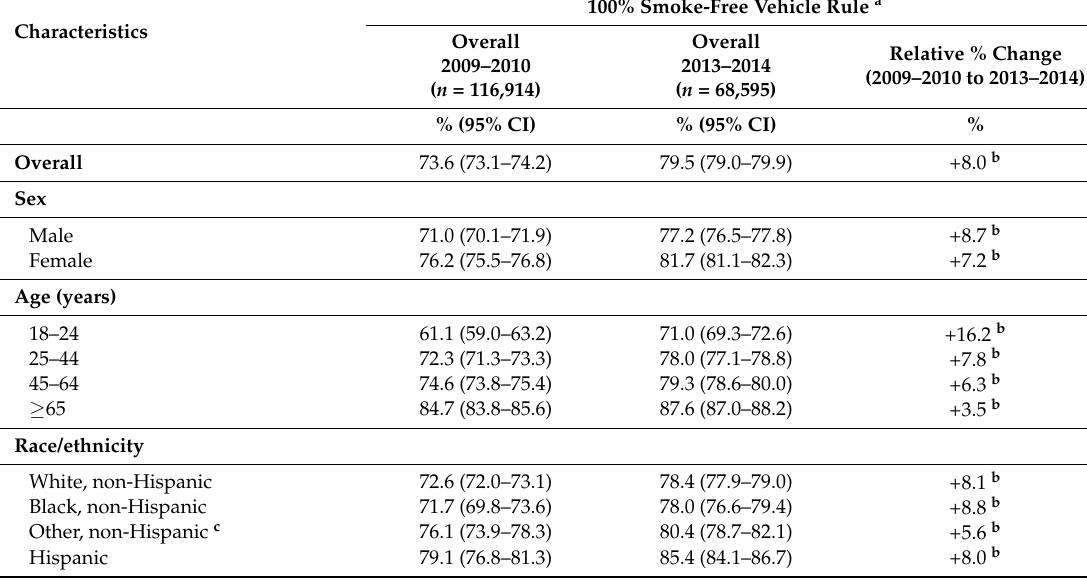
Table 1. Percentage of U.S. adults who reported having a 100% smoke-free vehicle rule, by selected sociodemographic characteristics and cigarette smoking status—National Adult Tobacco